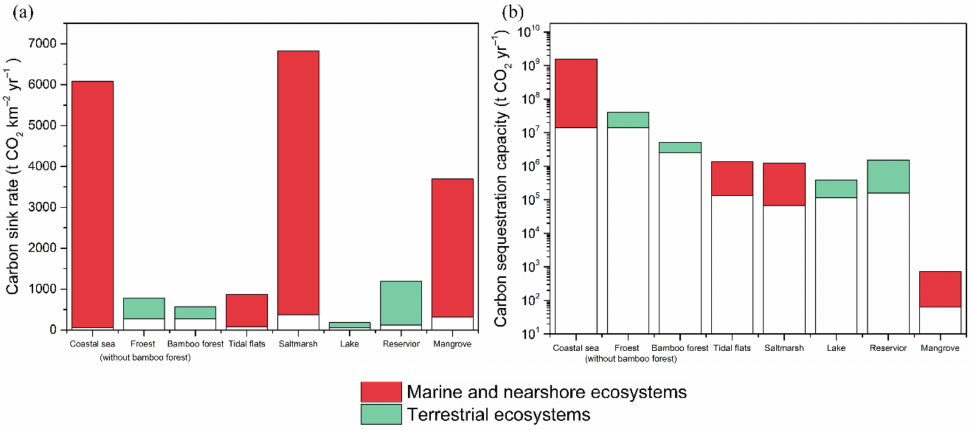
Figure 4. The range of the carbon sink rate and carbon sequestration capacity in Zhejiang Province. ( a ) The range of the carbon sink rate; ( b ) the range of the carbon sequestration capacity. Ranked according to the upper limit of the carbon sequestration